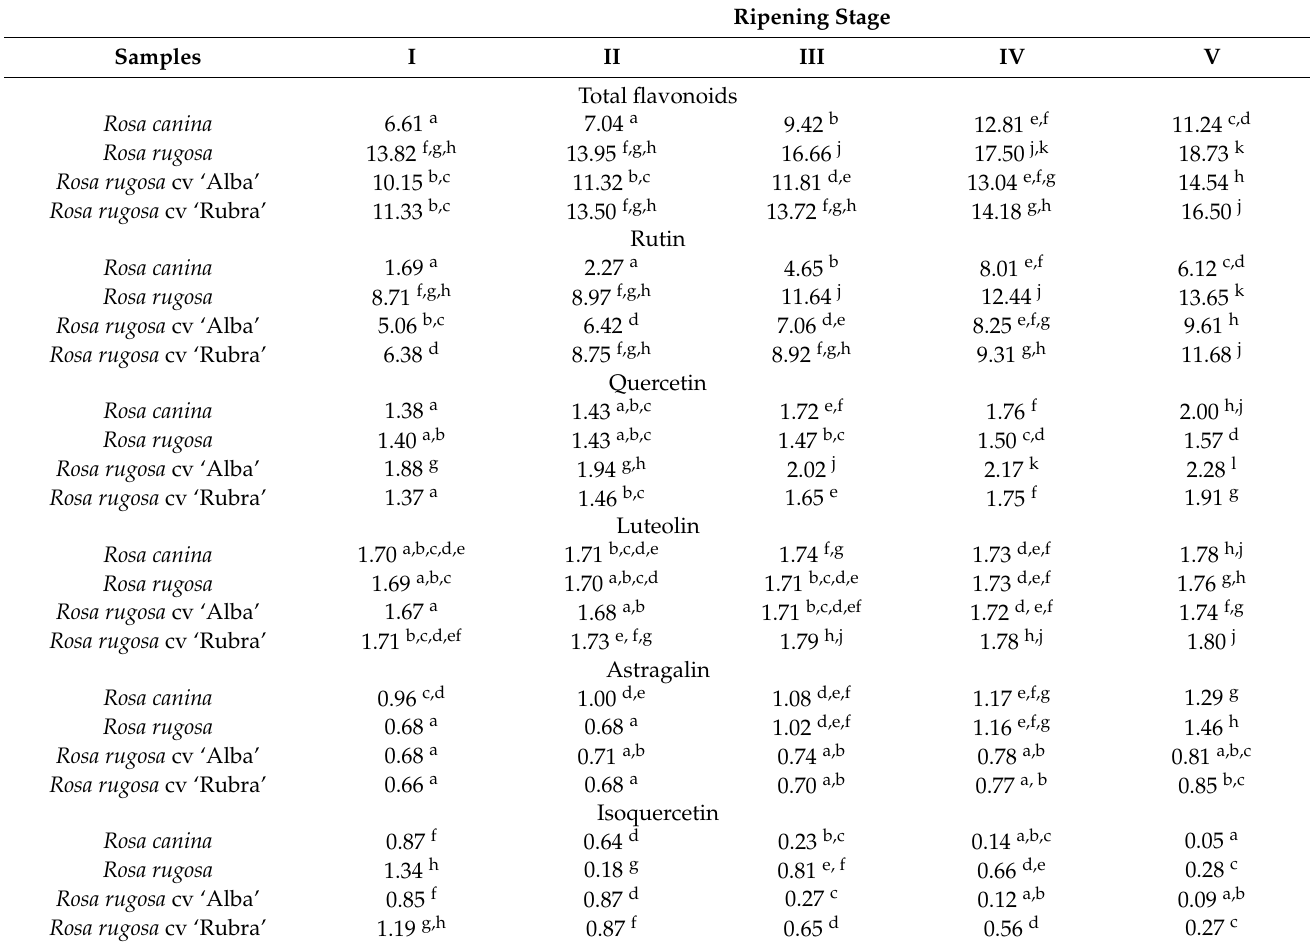
Table 5. Effects of ripening stage on the amounts of flavonoids in the rosehip fruits, mg 100 g − 1 DW. Ripening